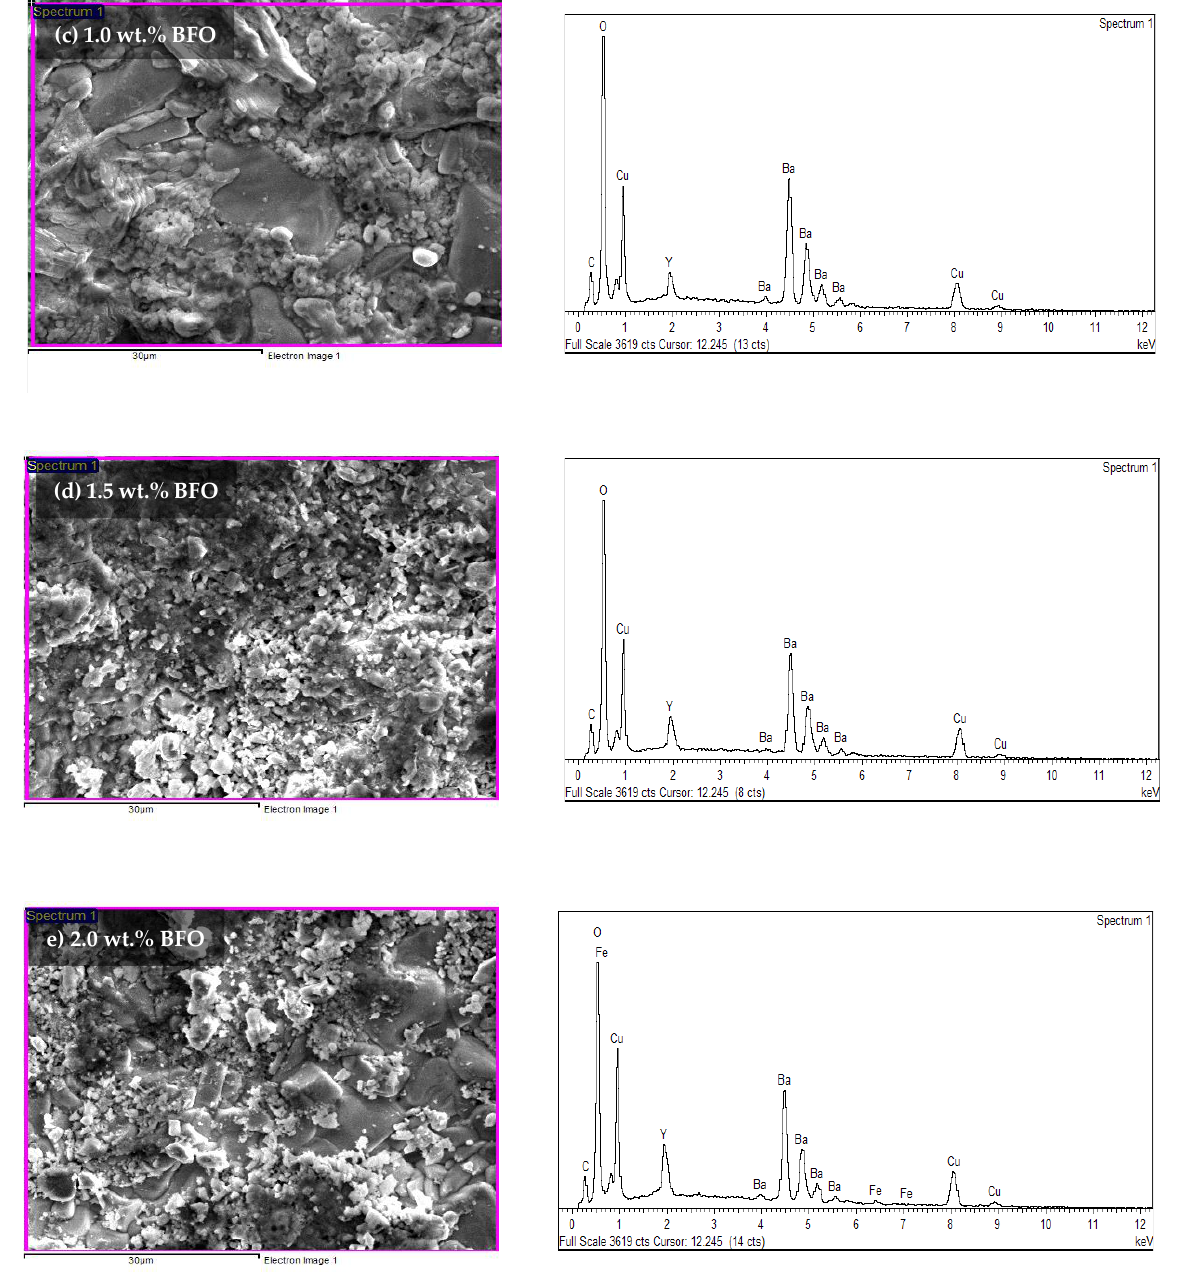
Table 6. The atomic percentages and atomic ratios for the Y-123 + x wt.% of BiFeO 3 .